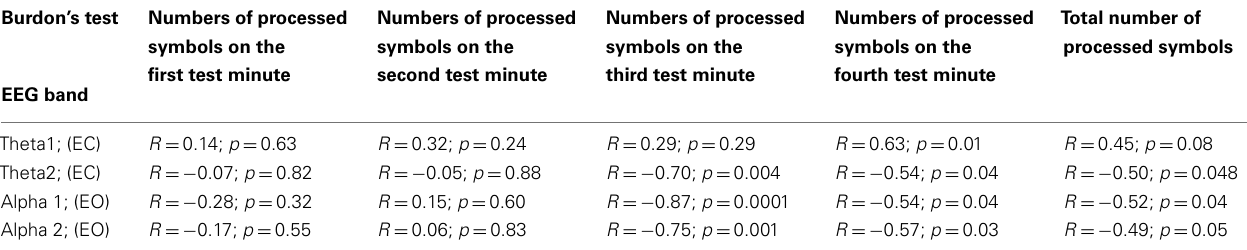
Table 2 |The correlations between EEG and neuropsychological parameters at 7–10days after